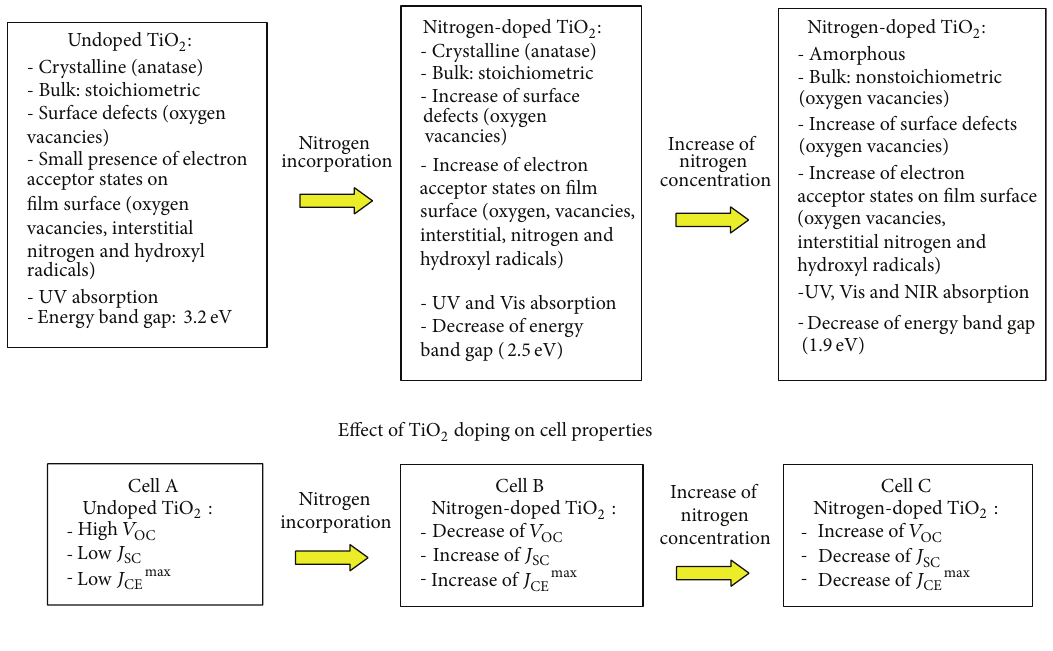
Figure 12: General properties of TiO 2 and DSSCs at different doping levels of